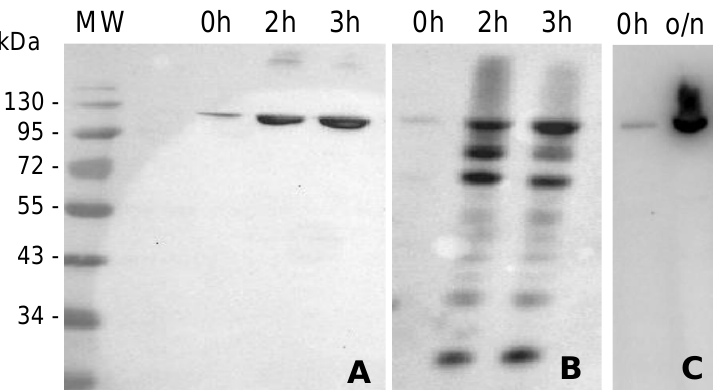
Figure 1. Production of MVP-H6 protein. Total cell pellets obtained from cultures induced either for 3 h at 37 °C ( A , B ) or o/n at 20 °C ( C ) were submitted to SDS-PAGE and further Western blots devel- oped with an anti-His monoclonal antibody ( A , C ), or with an anti-MVP polyclonal antibody ( B ).